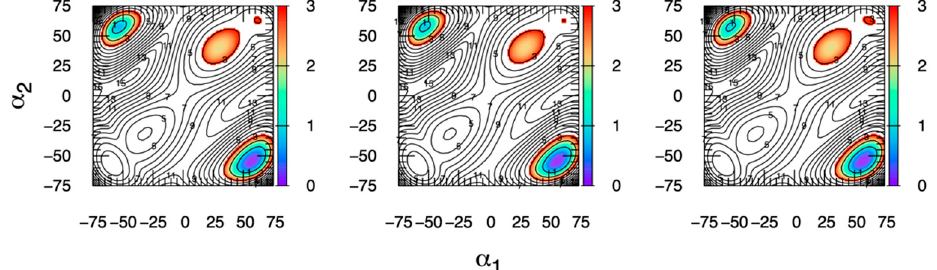
Figure 3. Me α IdoA ∆ G ( α 1 , α 2 ) from eABF simulation. Each panel is from a separate 200-ns simulation seeded with different initial random velocities. α 1 and α 2 are in degrees. ∆ G ( α 1 , α 2 ) is in kcal/mol, with contours drawn every 1 kcal/mol, colored from 0–3 kcal/mol, and labeled every 2 kcal/mol.